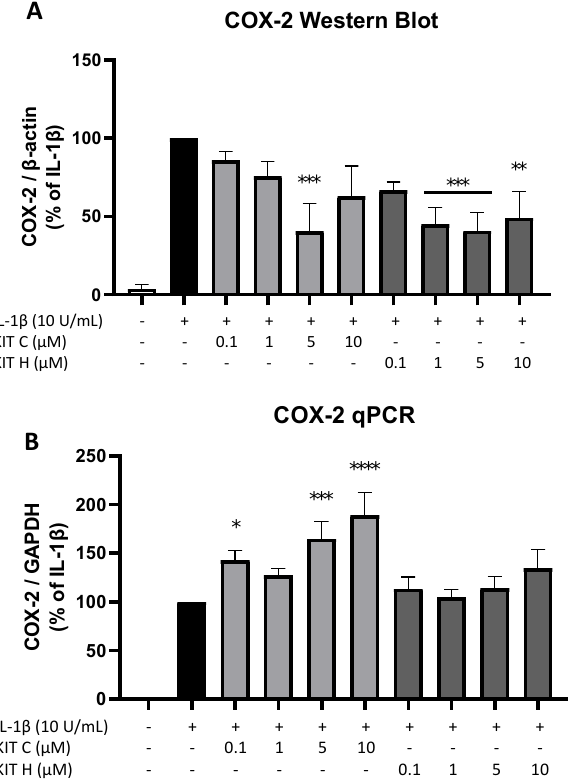
Figure 4. Effects of KIT C (light grey bars) and KIT H (dark grey bars) on COX-2 protein levels ( A ) and COX-2 mRNA expression ( B ) in IL-1 β -stimulated SK-N-SH cells. Cells were stimulated and analyzed as described under material and methods. Values are presented as the mean ± SEM of at least three independent experiments. Statistical analysis was performed using one-way ANOVA with Dunnett’s post hoc tests with * p < 0.05, ** p < 0.01, *** p < 0.001 and **** p < 0.0001 compared to IL-1 β.